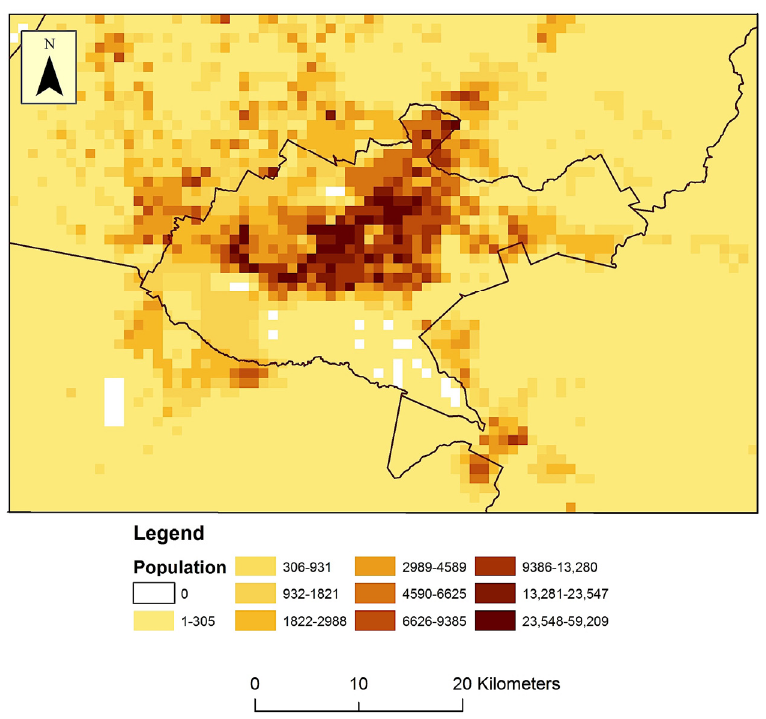
Figure 9. Population density per 1 km by 1 km in Nairobi and surrounding areas.